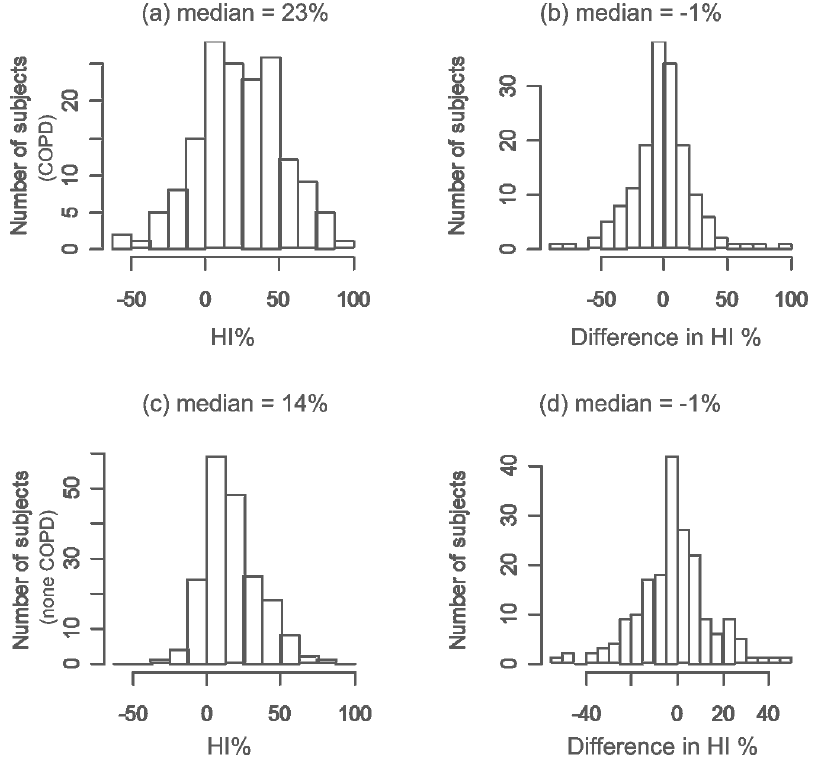
Figure 2. Distributions of computed HI% (left) and differences in computed HI% between the left and the right lungs (right). The top row represents the COPD patients (N=160), and the bottom row represents the non-COPD patients (N=190).